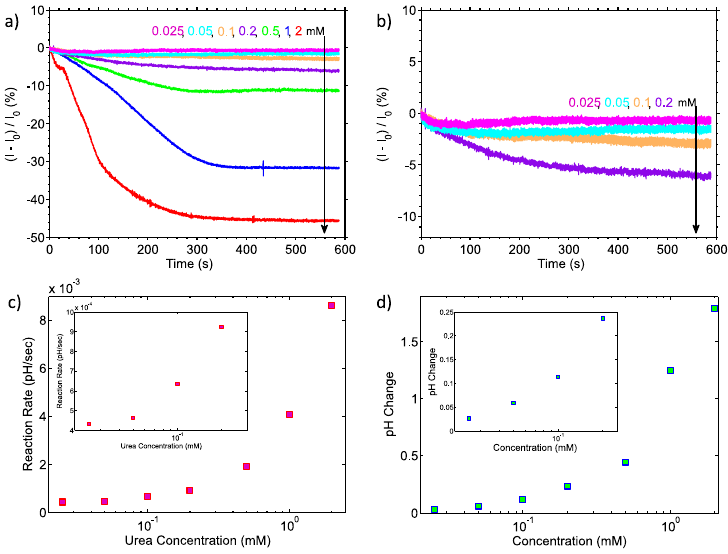
Figure 3. ( a ) Normalised drain current change with respect to time for different concentrations of urea; ( b ) Normalised drain current change for lower concentrations of urea; ( c ) Reaction rate vs urea concentrations; ( d ) Final extracted value of pH change as a function of urea concentration.